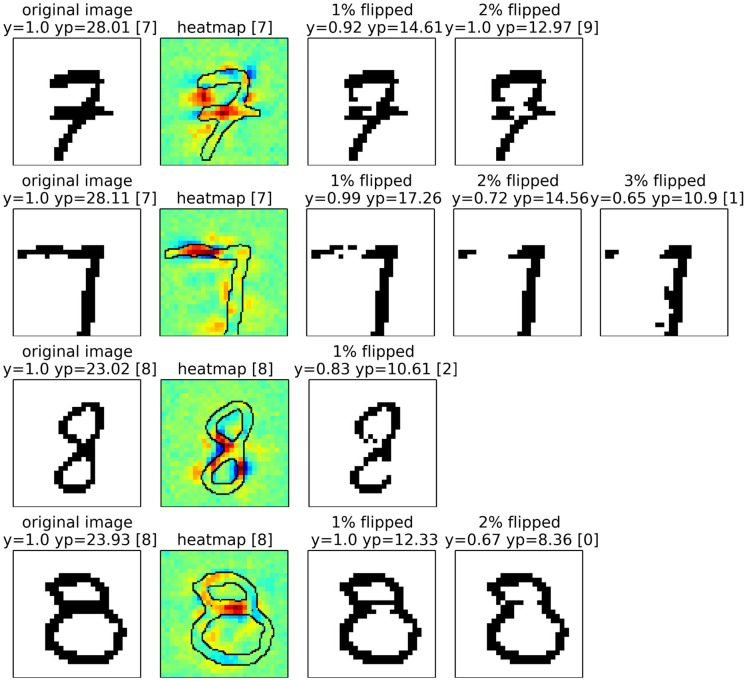
Examples of images with an increasing amount of flipped pixels and the corresponding predictions of the classifier.Here pixels are flipped away from the class label given in parentheses above the heatmap. Pixels were flipped in steps of 1% of all pixels until the predicted class label changed. The plots show the output of the softmax function y and the output score of the preceding linear layer yp. The pixels were sorted before flipping in decreasing order of the pixel-wise score, i.e. highest scoring pixels were flipped first. In this panel the heatmap was computed for the classifier which produced the highest score, i.e. for the predicted class label. The originally predicted label is given on the leftmost image in parentheses, the predicted label after the switch of the prediction is given in the rightmost image.